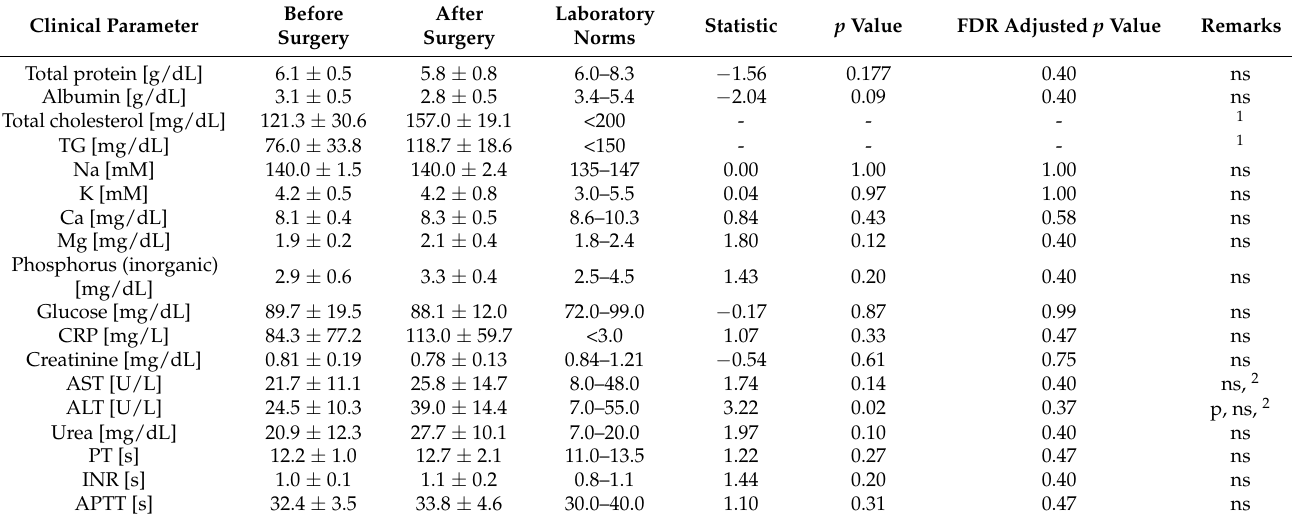
Table 2. Statistical analysis of clinical characteristics of patients in the study.